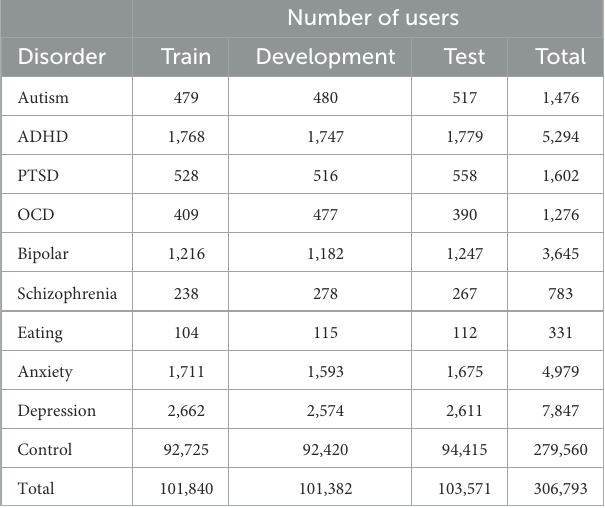
TABLE 4 SMHD dataset with the number of users under each mental disorder and data partition.